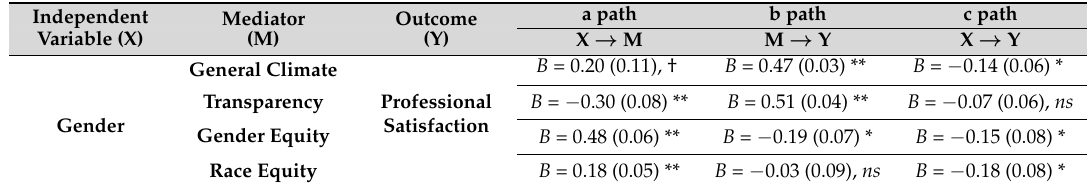
Table 3. Gender differences in perceived climate and professional